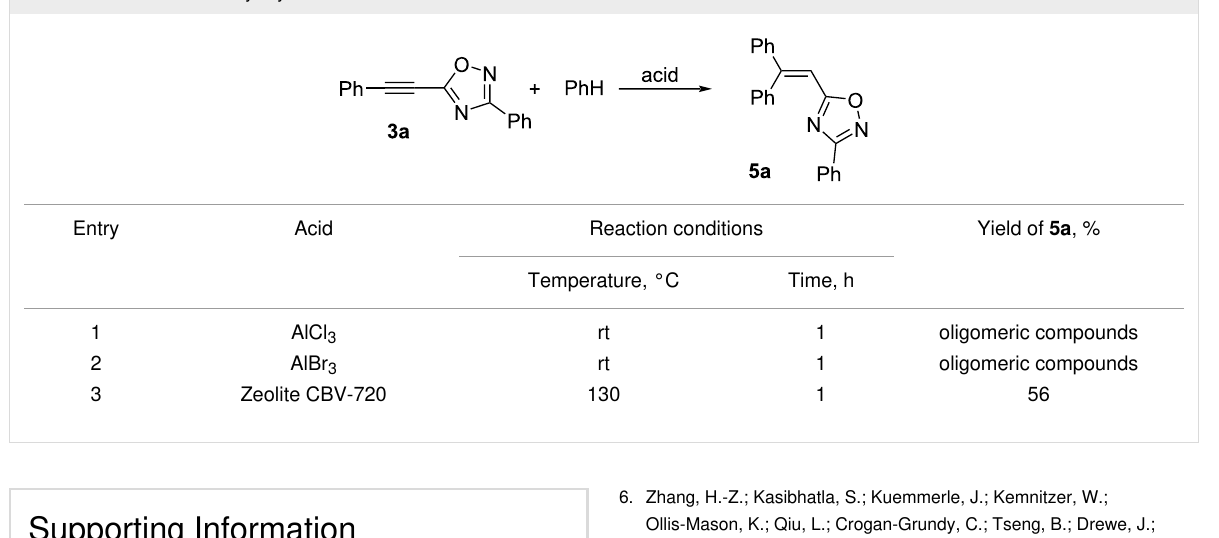
Table 2: Reactions of 5-acetylenyloxadiazole 3a with benzene under the action of various